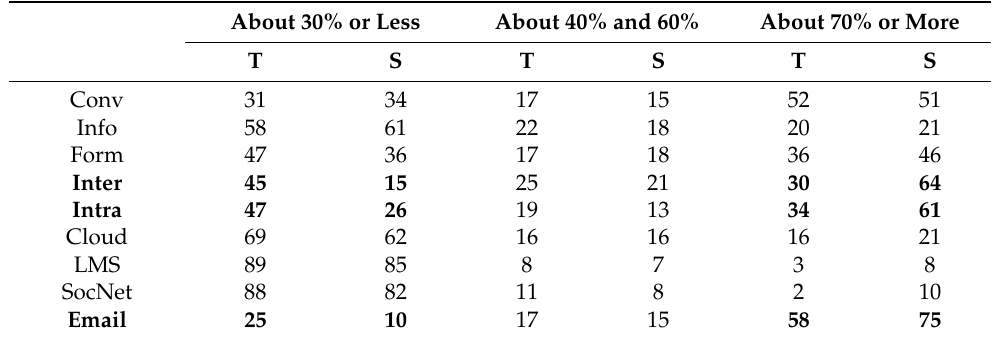
Table 6. Ways of finding information in the area of administrative activities regarding the field of